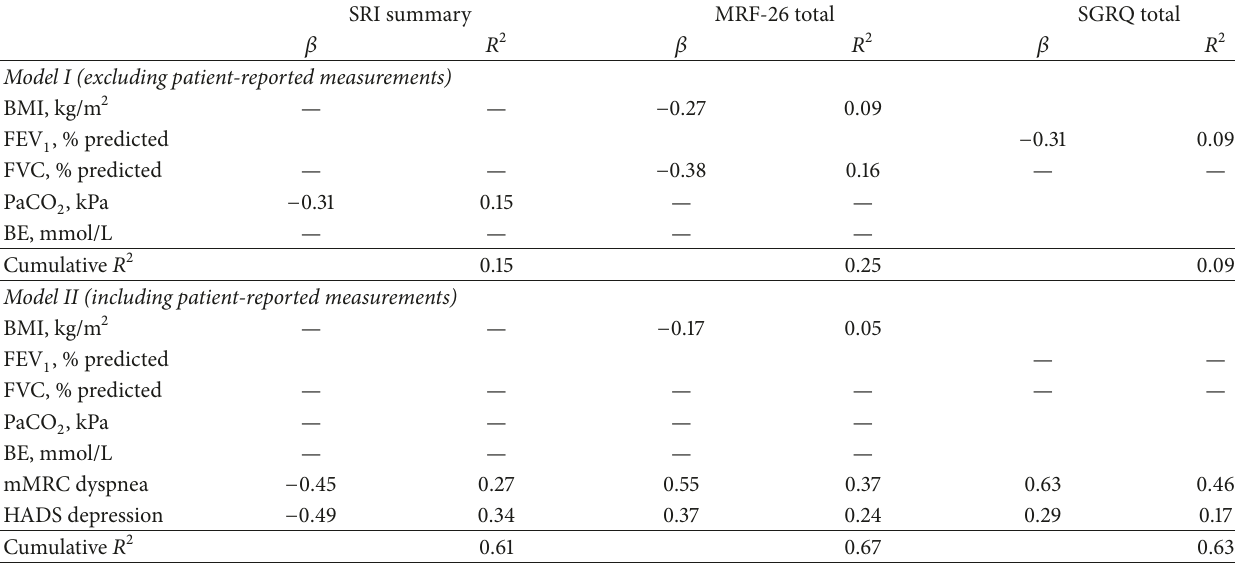
Table 4: Results of multiple regression